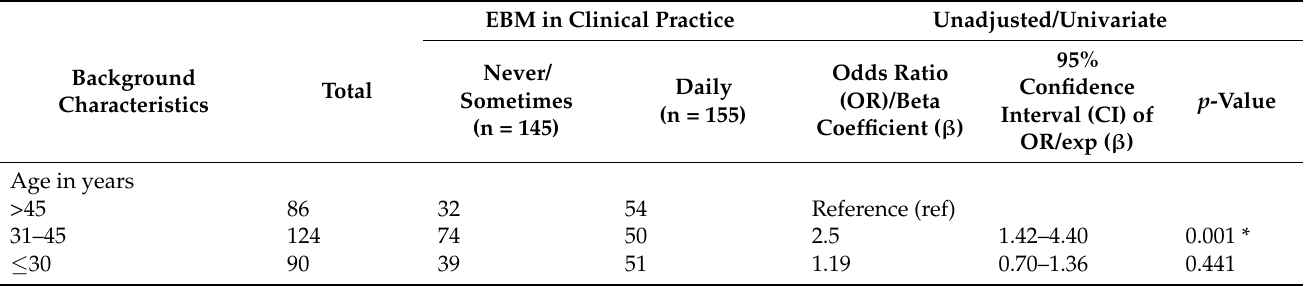
Table 5. Binomial logistic regression analysis between background characteristics and EBM prac- tice